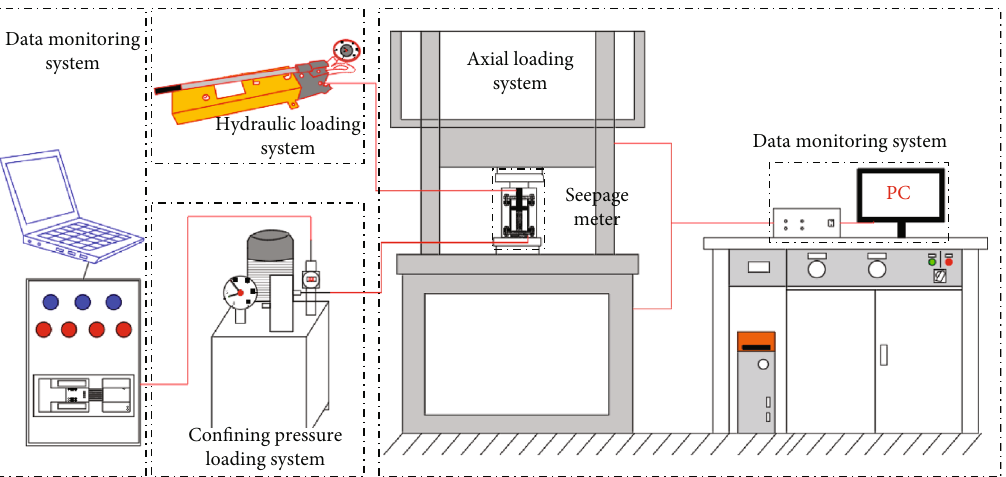
Figure 5: Schematic of the seepage